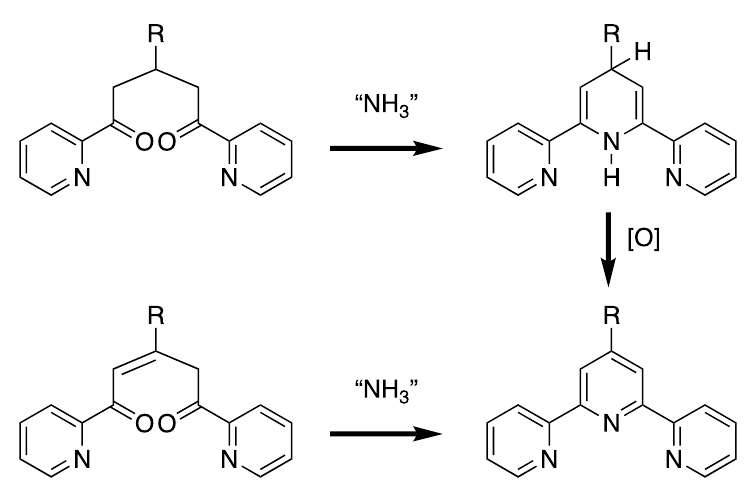
Scheme 1. The typical synthetic strategy for a 2, 2′ : 6′ ,2 ′′ -tpy involves the cyclization of